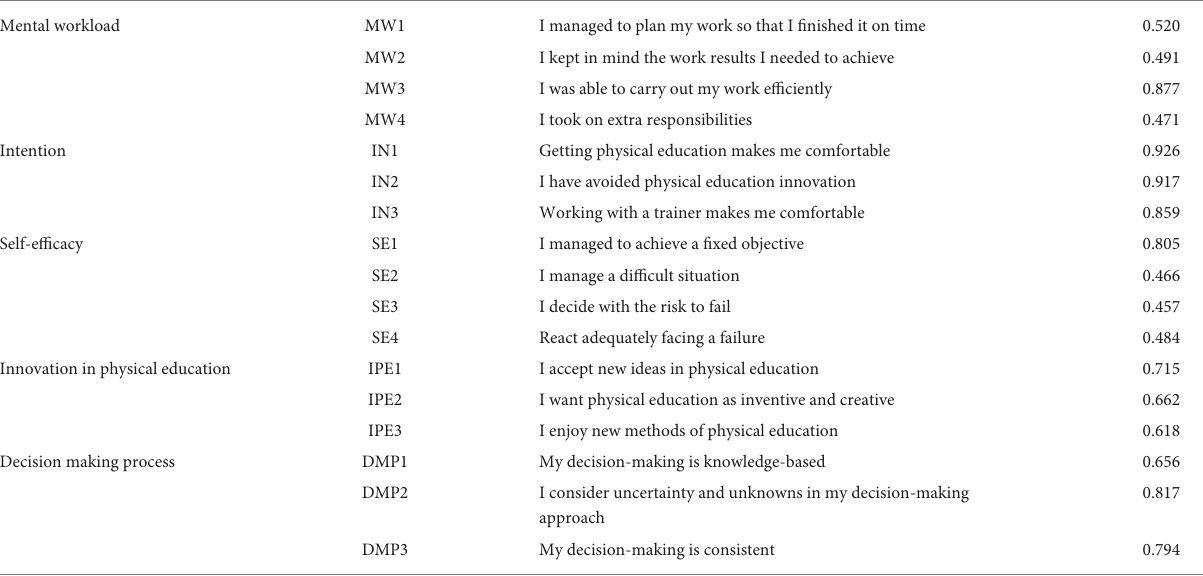
TABLE 1 Results of confirmatory factor analysis.